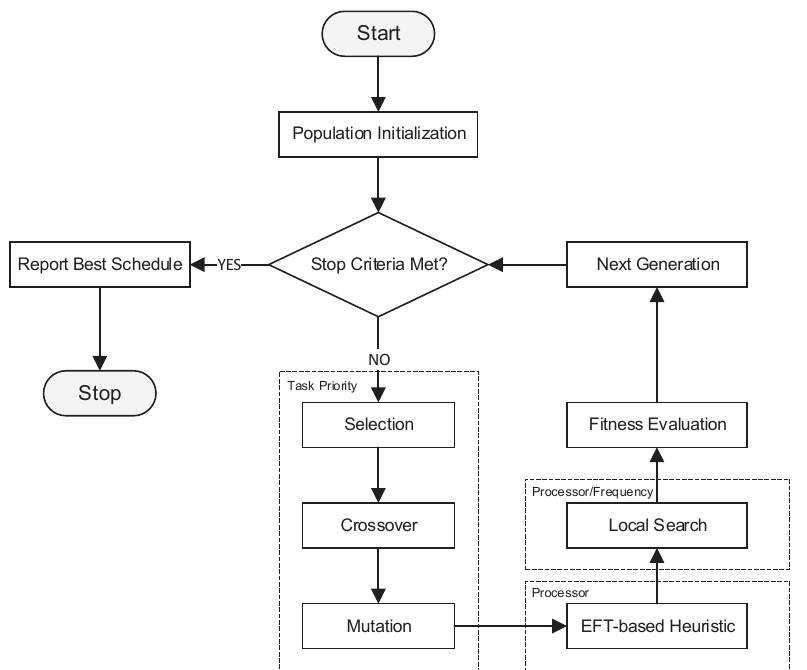
Figure 2. The algorithm flowchart of the memetic algorithm (MA)-dynamic voltage frequency scaling (DVFS). EFT, earliest finish